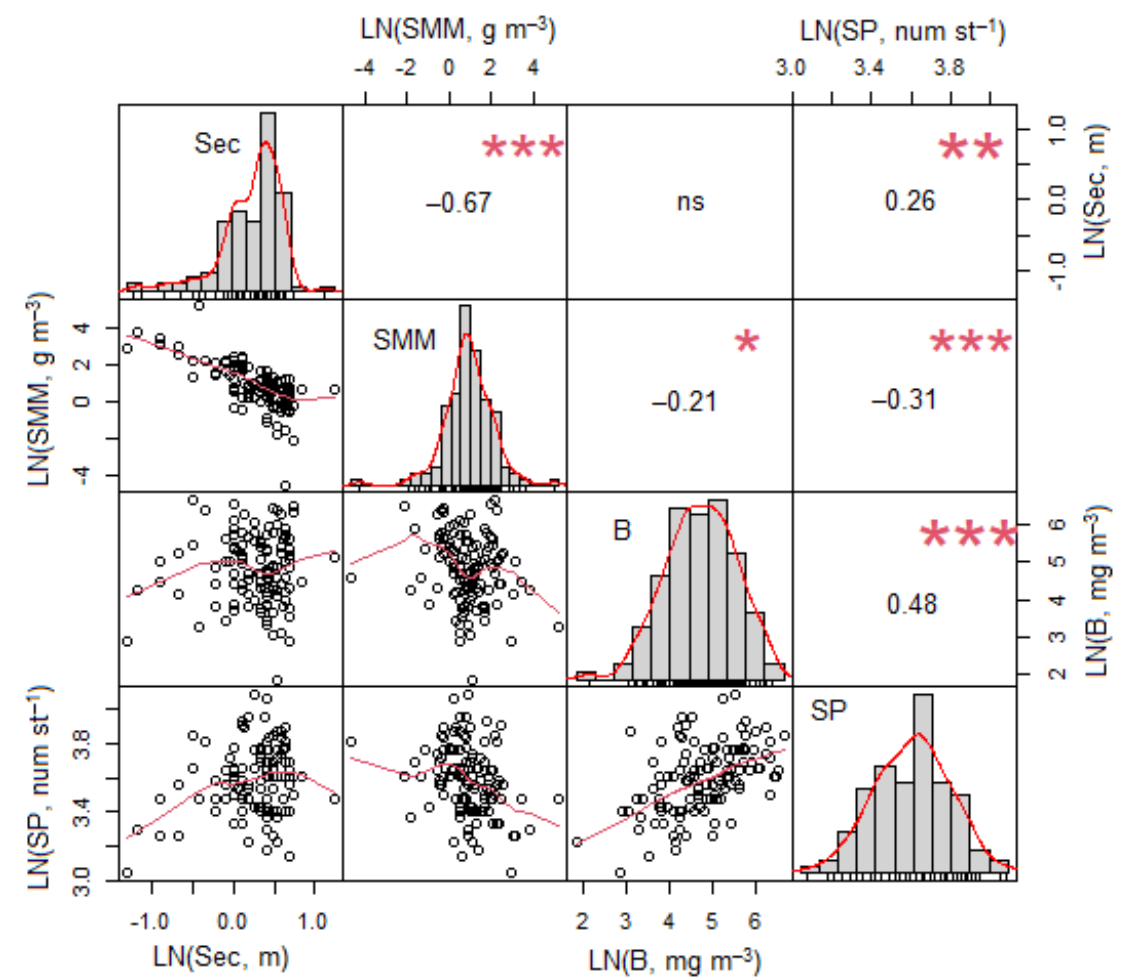
Figure 5. Relationships between Secchi depth (Sec), the concentration of suspended particulate mineral matter (SMM), biomass (B), and species richness (SP) in the Neva Estuary in 2003–2020. The graphs on the left are the bivariate scatterplots, with a fitted line; the central histograms show the residuals from the linear model; and the values on the right are Pearson’s correlation coefficients. Asterisks indicate the significance of the correlation. (* p < 0.05; ** p < 0.01; *** p < 0.001). ns—not significant; m—meter; m 3 —cubic meter; g—gramm; mg—milligram; num—number; st—station.